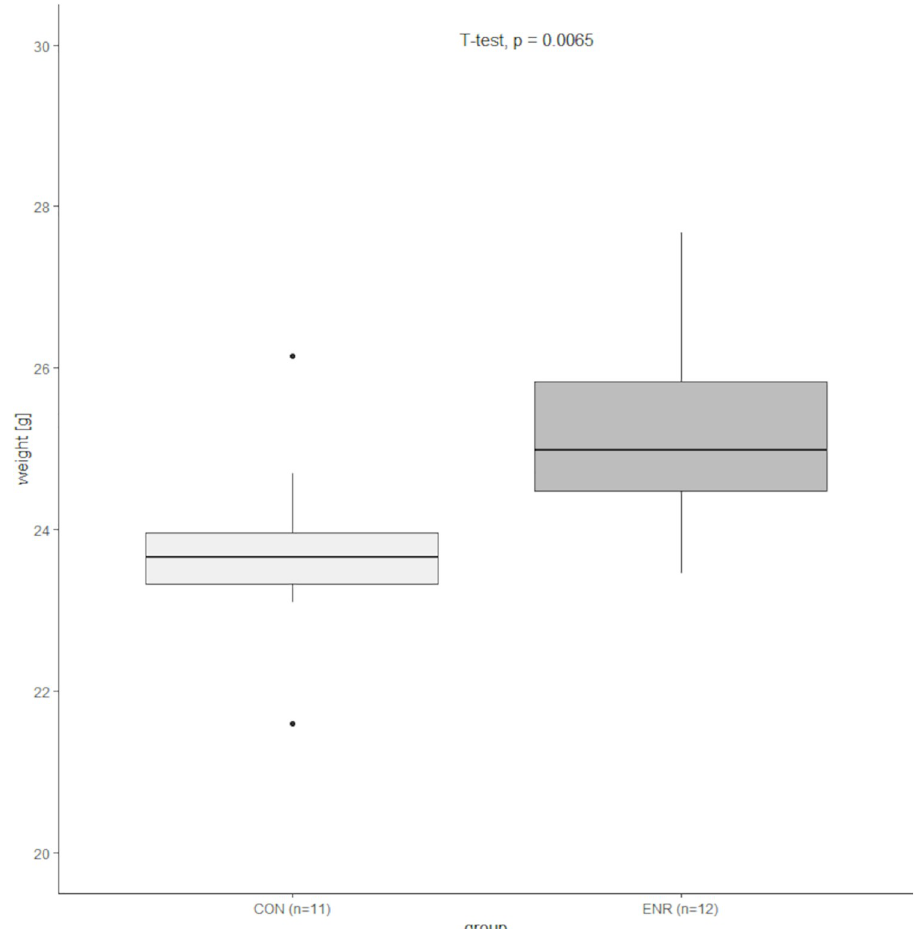
Fig 5. Body weight of enriched (n = 12) and conventional (n = 11) housed mice in [g]. Boxplots depict the median value (horizontal line), the interquartile range from 25th to 75th percentile of the data (box), and the minimum and maximum values lying above or below the box within 1.5 times the interquartile range (vertical lines), outliers ( < q0.25–1.5 x IQR or > q0.75 + 1.5 x IQR) are drawn as filled